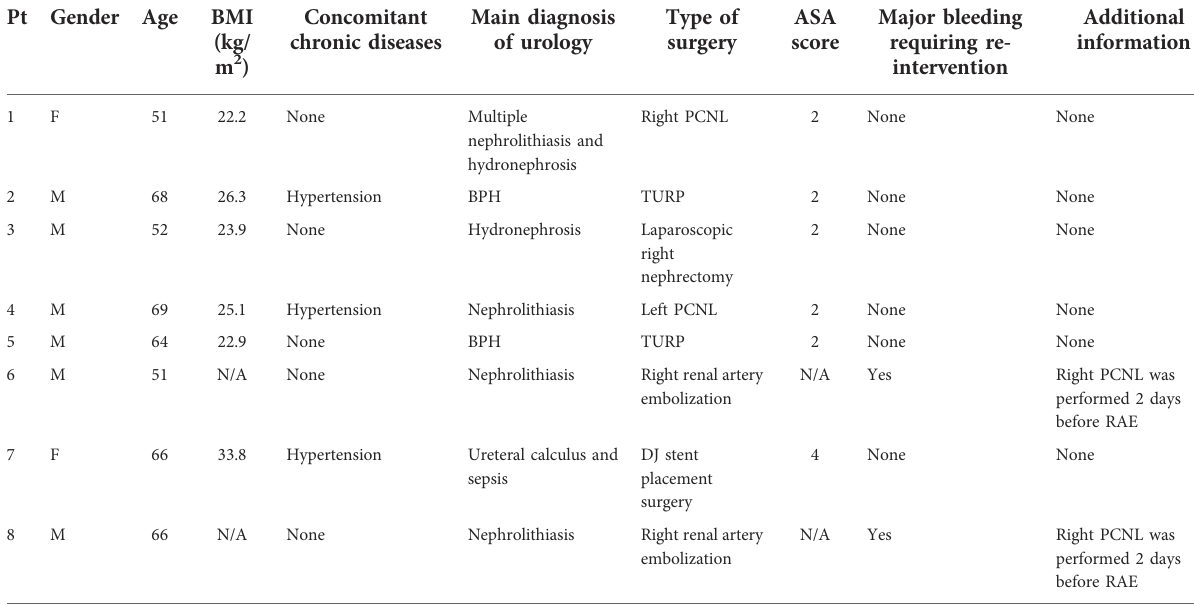
TABLE 1 Baseline characteristics of the enrolled patients. Pt Gender